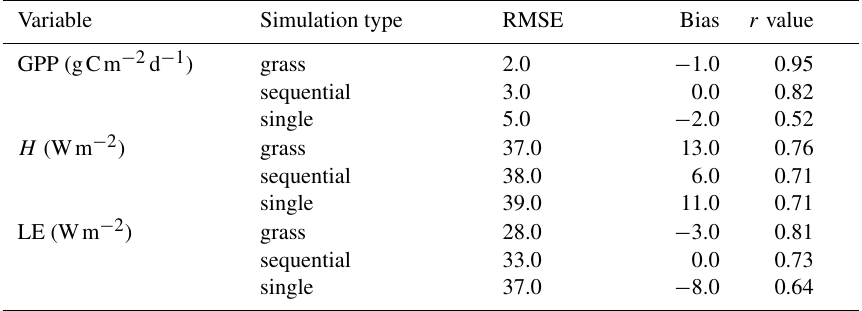
Table 6. Table of statistics comparing the Avignon simulations with observations for each type of run: Avi-single (single), Avi-sequential (sequential) and Avi-grass (without the crop model).